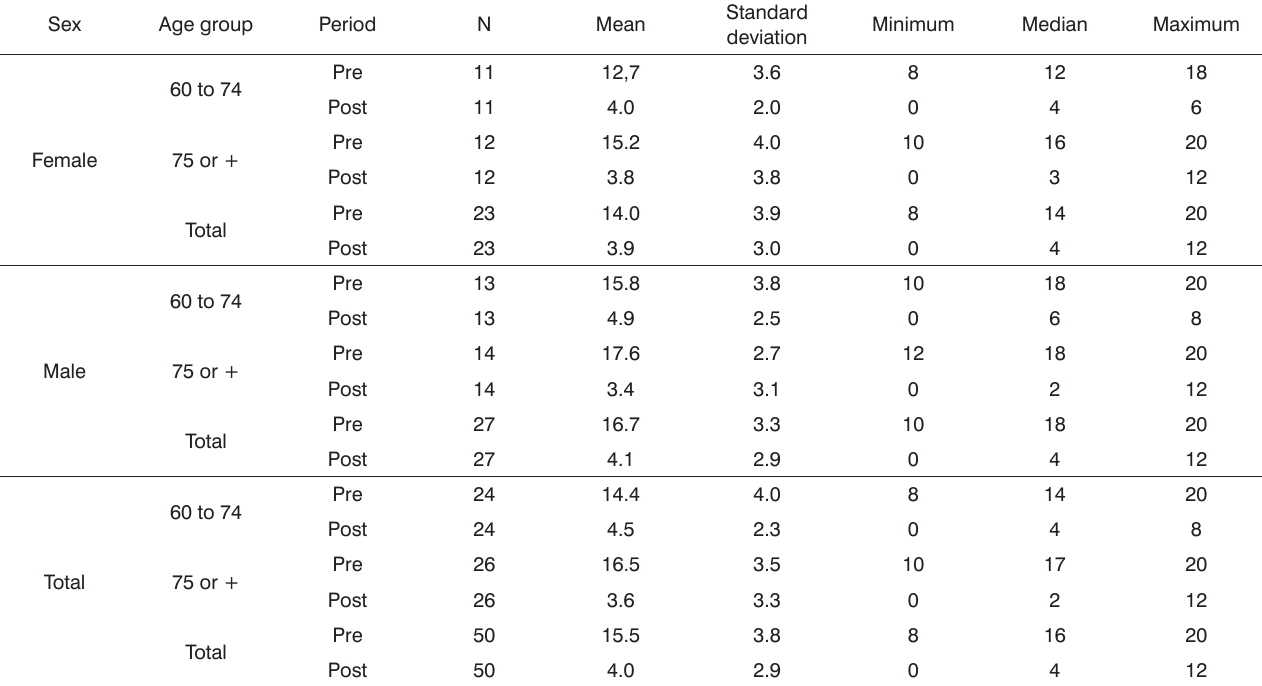
Table 2. Analysis of variance and descriptive statistics for the emotional scale scores in the HHIE, according to sex and age group.